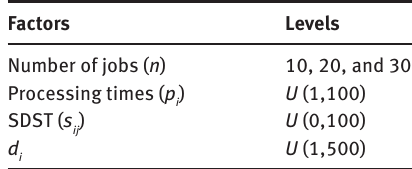
Table 1: Factors and their